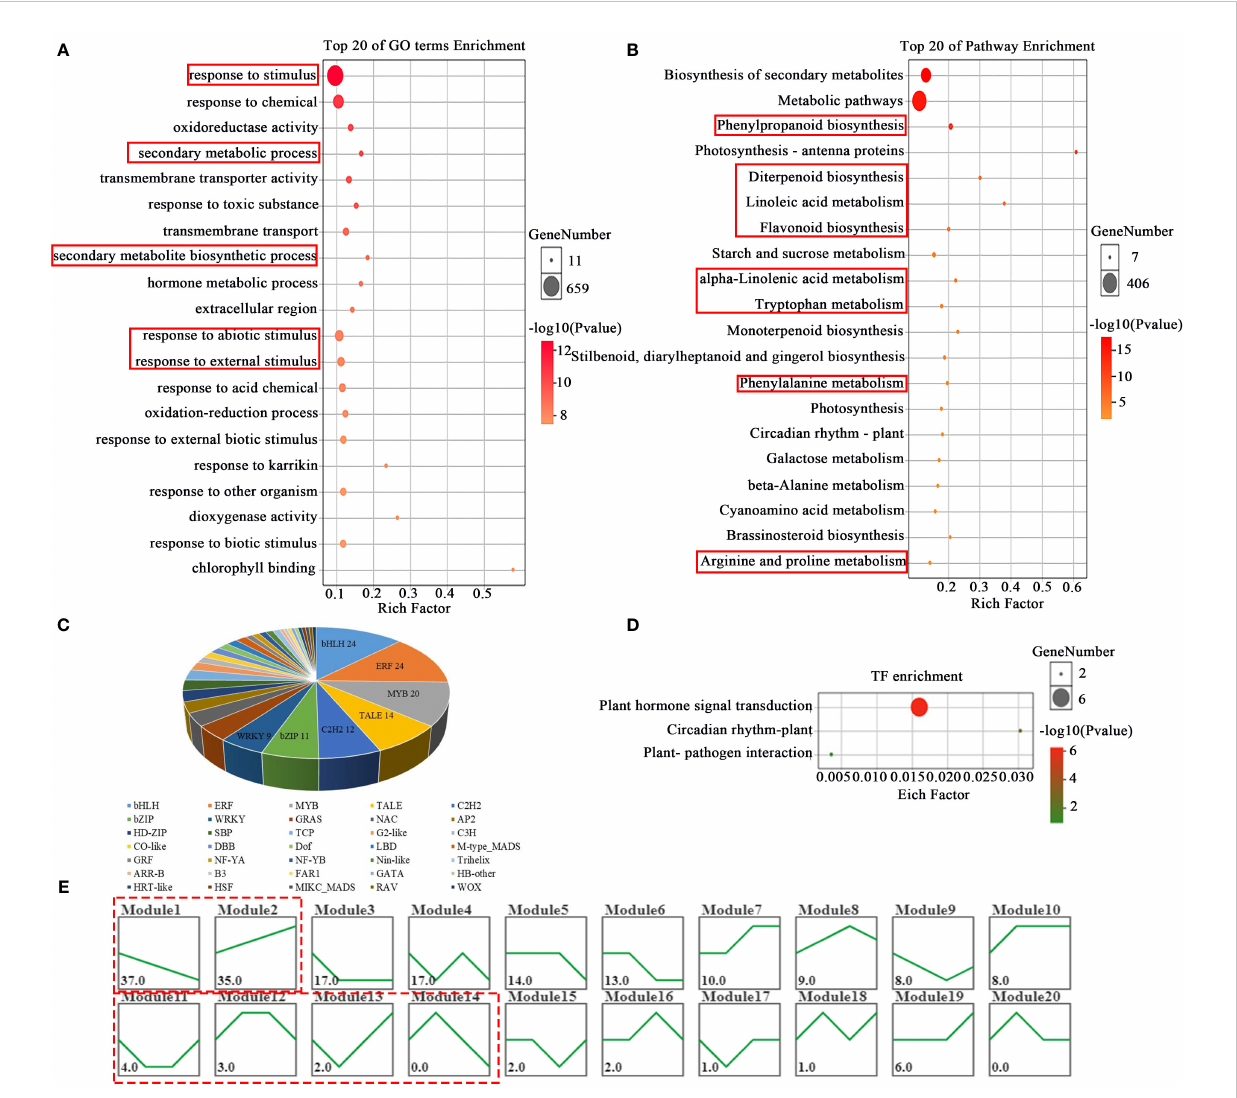
FIGURE 3 GO and KEGG enrichment analysis and TF prediction of DEGs in bud and one leaf of tea plant at different temperature treatments. The enriched GO (A) and KEGG (B) pathway of DEGs. Transcription factor prediction (C) of DEGs. The enriched KEGG pathway (D) of TFs. The expression trend analysis (E) of